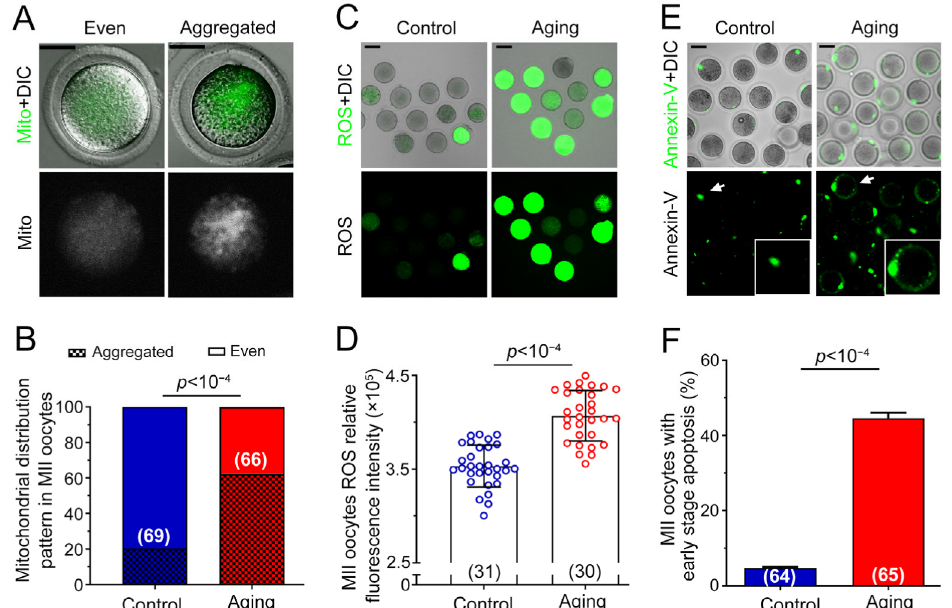
Figure 2. Abnormalities of oocytes were observed in POA. ( A ) Typical images of mitochondria distri- bution in oocytes. The green fluorescence represents mitotracker green FM combined specifically with mitochondria. Scale bar = 20 µ m. ( B ) The proportion of oocyte mitochondria distribution patterns. ( C ) Representative images of ROS accumulation inside oocytes. The green fluorescence indicates ROS in oocytes detected using a DCFH-DA fluorescent probe. Scale bar = 100 µ m. ( D ) Statistics of oocyte ROS fluorescence intensity. Each blue and red circle represents one detected oocyte in the control and aging groups, respectively. ( E ) Representative images of oocytes with early apoptosis. The white arrows indicate the embryos for enlargement. The green fluorescence Annexin-V on the oocyte cell membrane indicates early apoptosis. Scale bar = 20 µ m. ( F ) Percentage of oocytes with early apoptosis. The data are presented as mean ± SD. p < 0.05 indicates a statistically significant difference. The number of oocytes is shown in brackets in the